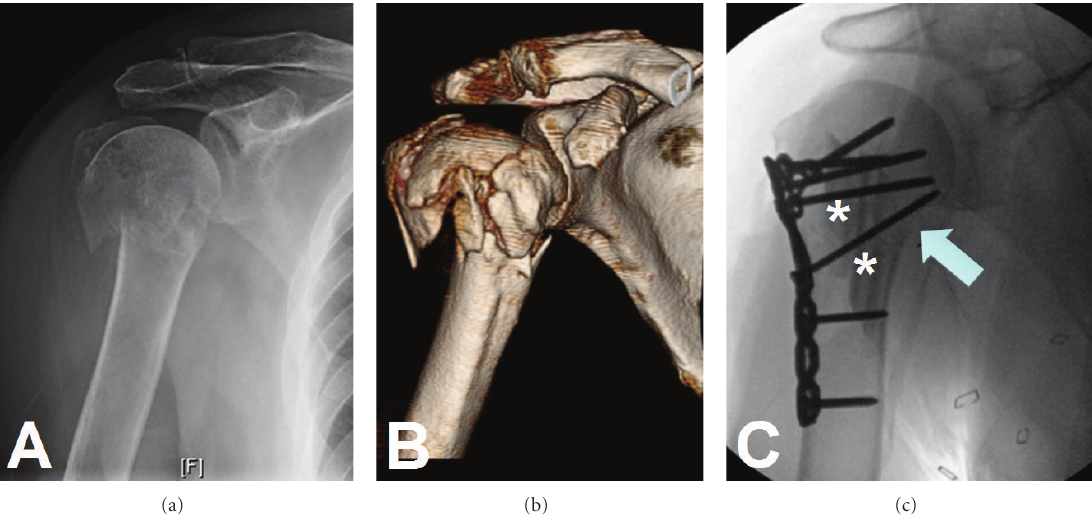
Figure 5: Radiograph (a) of a proximal humerus fracture. The CT scan with 3D reconstruction (b) adds significant detail and aids in preoperative planning. Osteosynthesis was carried out (c) with the use of intramedullary fibulas (asterisks) and particular attention paid to restoration of the medial calcar